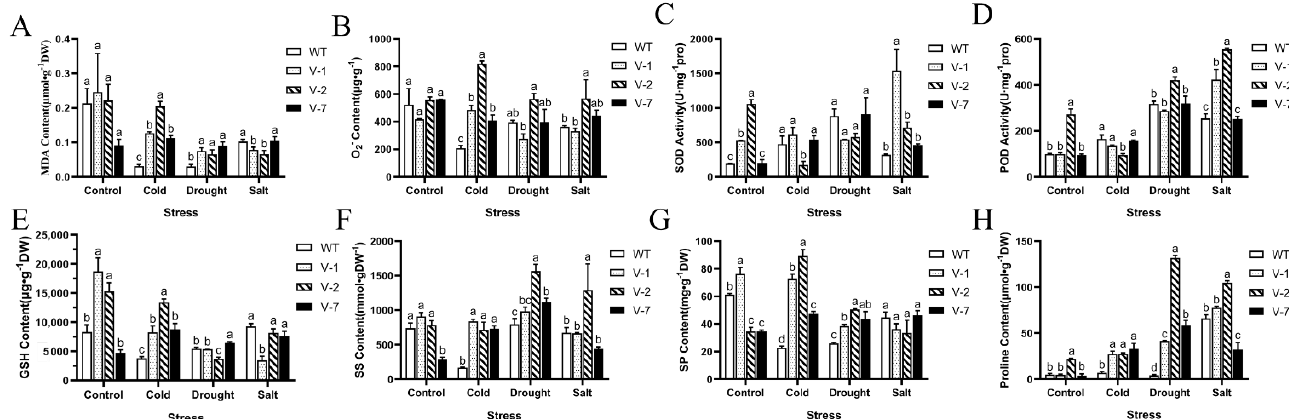
Figure 4. Physiological analysis of the cold, drought and salt stress tolerance of transgenic tobacco plants overexpressing MsVDAC : ( A ) MDA content; ( B ) Superoxide anion radical (O 2 - ) content; ( C ) SOD activity; ( D ) POD activity; ( E ) Reduced GSH content; ( F ) SS content; ( G ) SP content; ( H ) Free proline content. WT: wild type. V-1: line 1. V-2: line 2. V-7: line 7. The error bars represent the means ± SDs of three independent biological replicates. The different letters represent significant differences (α = 0.05).